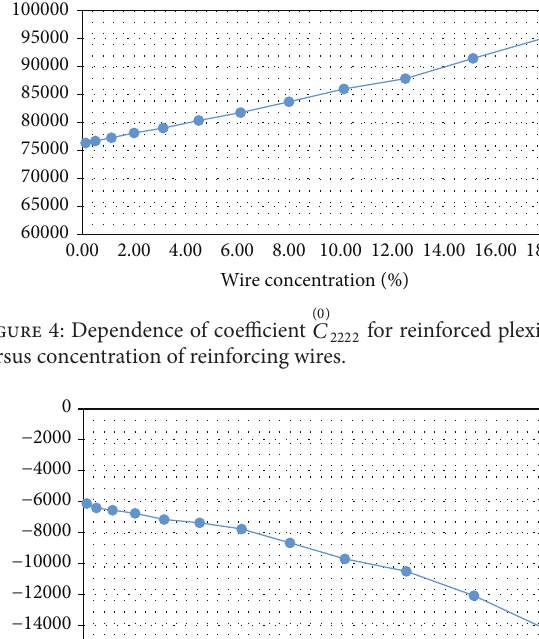
Figure 1: Dependence of coefficient versus concentration of reinforcing wires.